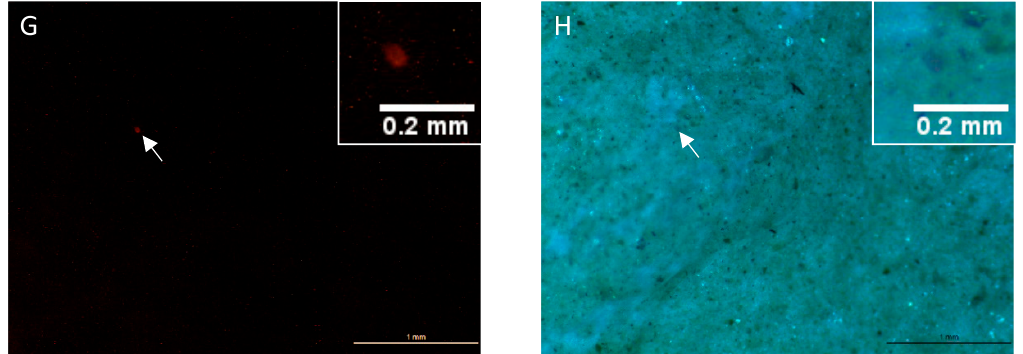
Figure 2. Particles ( ↖ ), previously identified by fluorescence under 254 nm after Nile Red staining, under visible light and photographed by digital stereomicroscope ( A – D ) and their corresponding details (top right corner of each picture). Particles observed under 254 nm ( E , G ); Visualization improved by maxing out Color Balance for red and yellow on Adobe Photoshop CS4) and under visible light ( F , H ), correspondingly. A white-blue fluorescent fiber likely originated from the cotton lab coat ( E ).